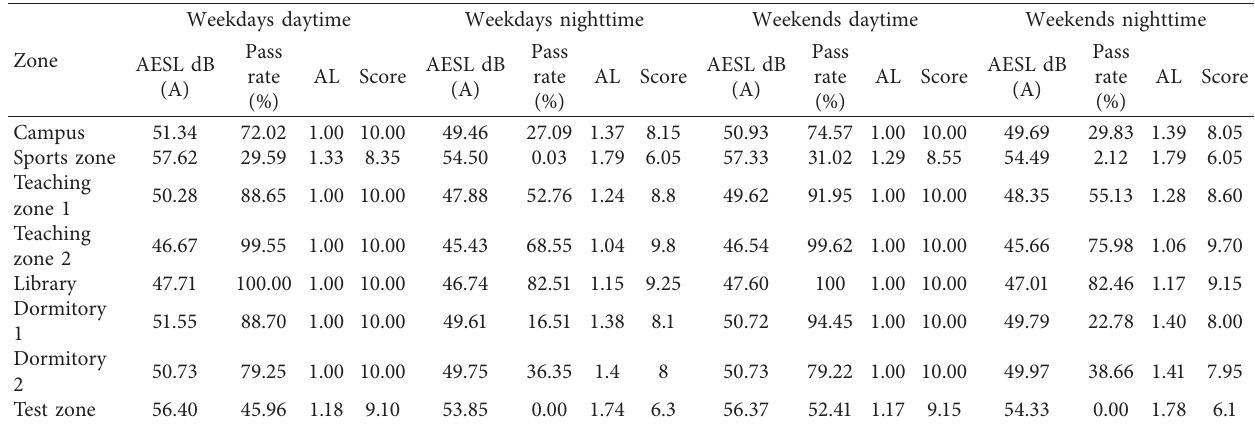
Figure 5: Simulation of the current status of Zhejiang University of Technology: (a) weekdays daytime, (b) weekdays nighttime, (c) weekends daytime, and (d) weekends nighttime. Table 2: Simulation of the current status of each